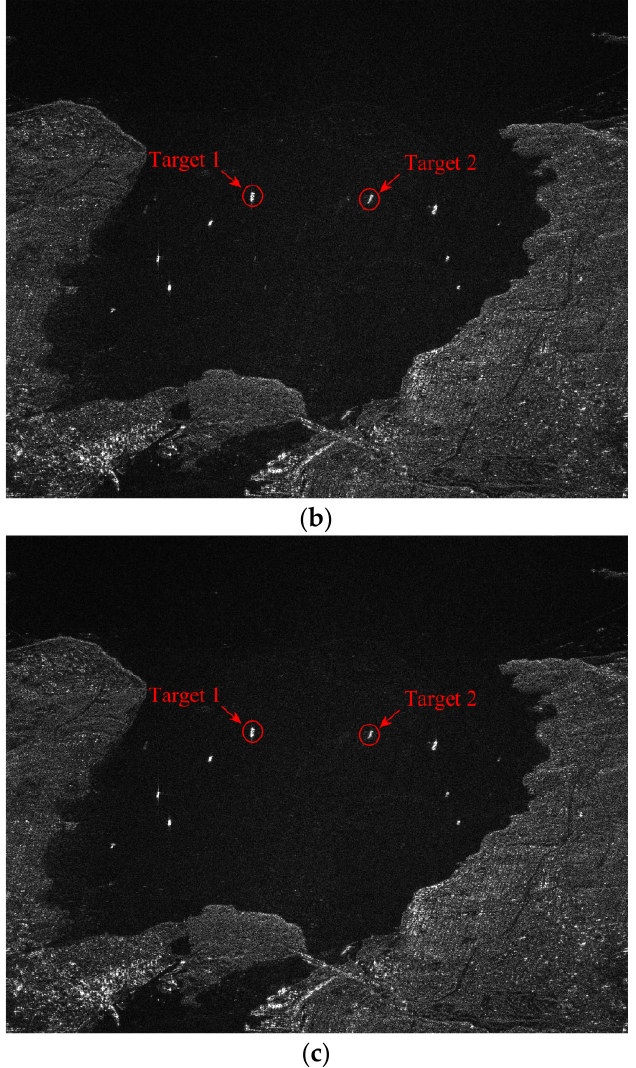
Figure 4. Multi-channel SAR image results with different calibrations (horizontal azimuth, vertical range). ( a ) Result without calibration. ( b ) Result with subspace projection calibration. ( c ) Result with the proposed calibration.